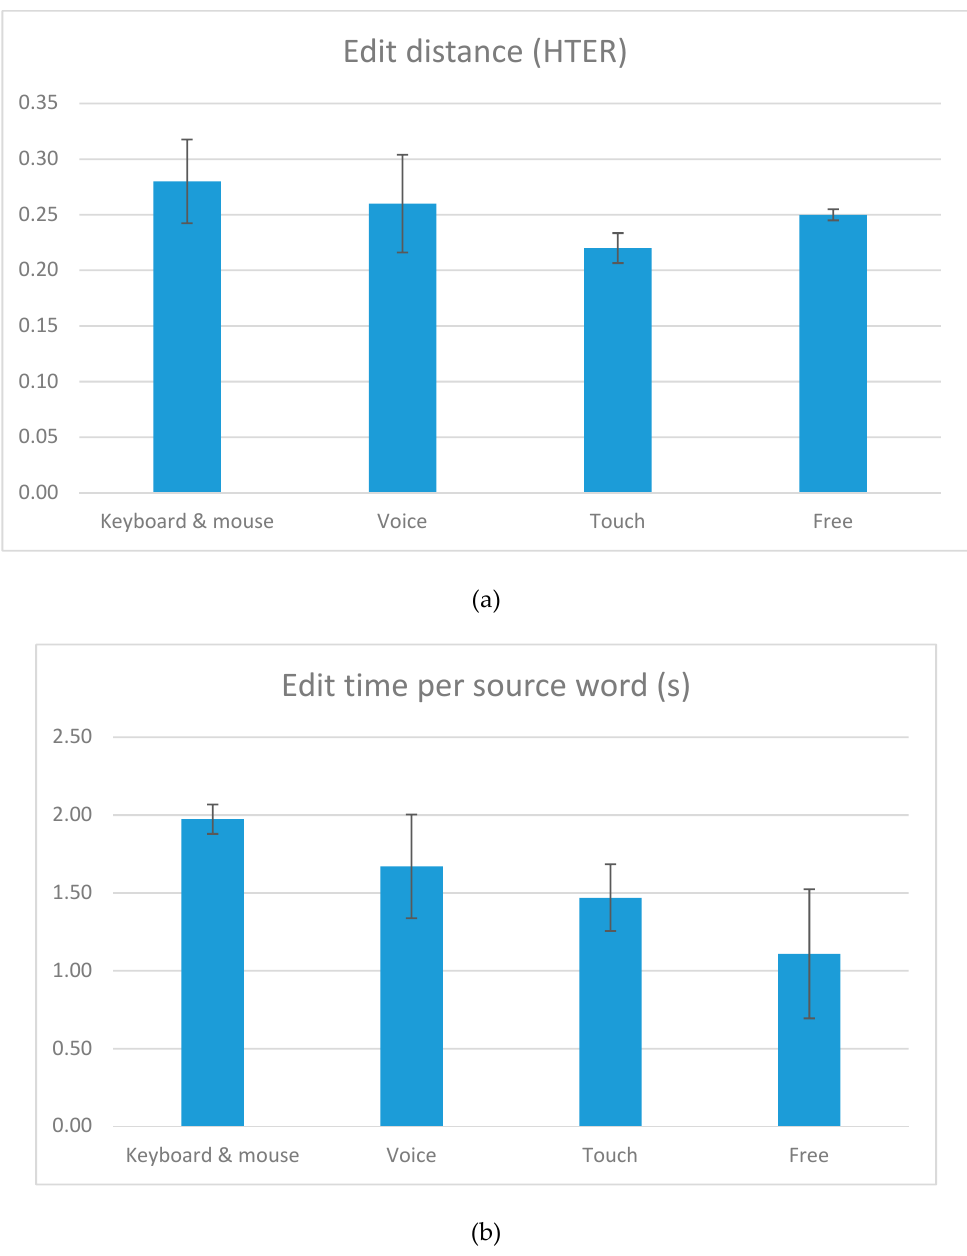
Figure 9. Results for edit distance ( a ) and edit time ( b )—1st round of tests.